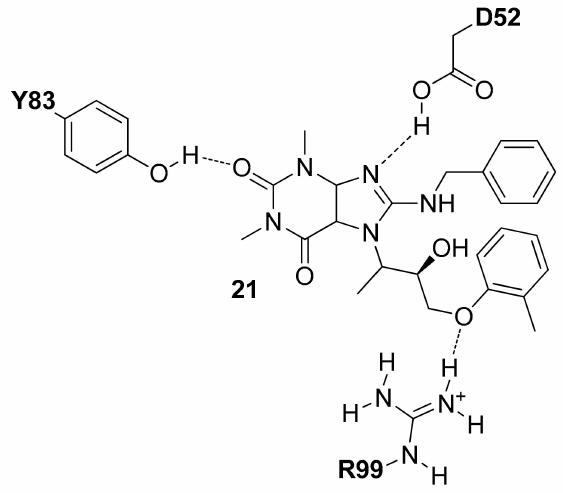
Figure 9. Schematic 2D representation of the 21 – h LDH5 H-bond